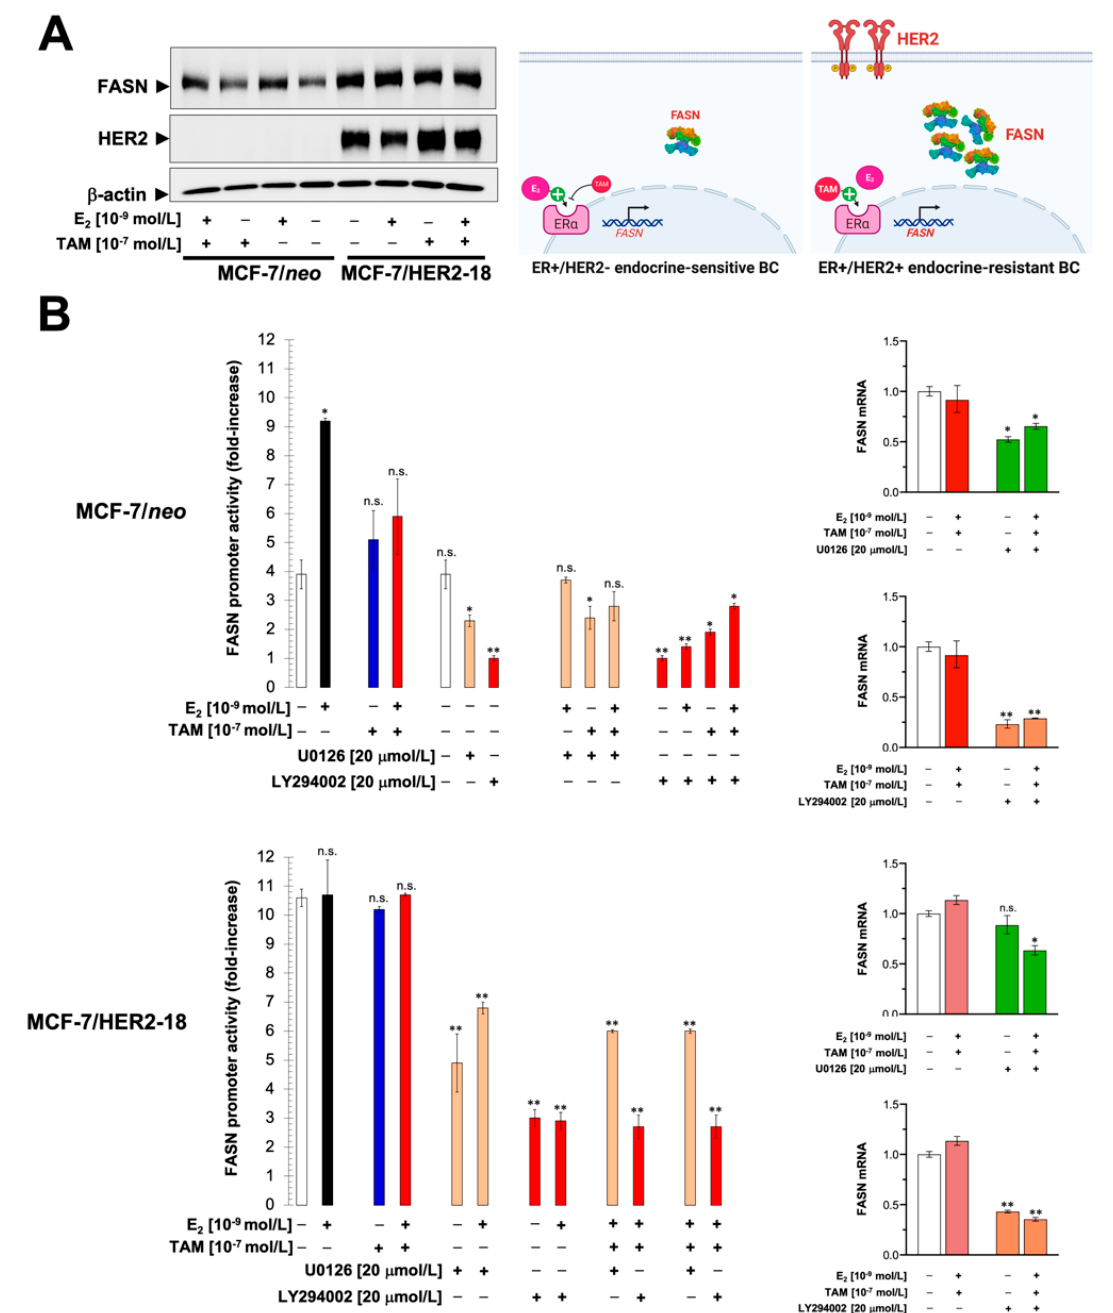
Figure 2. Estradiol and tamoxifen-unresponsive regulation of FASN expression in ER/HER2-positive breast cancer cells. ( A ) FASN protein expression in MCF-7/ neo and MCF-7/HER2-18 cells cultured in the presence or absence of estradiol (E 2 ), tamoxifen (TAM), or their combinations. Shown is a representative immunoblotting analysis. Similar results were obtained in 3 independent experiments. ( B) Left. FASN promoter activity in MCF-7/neo and MCF-7/HER2-18 cells cultured in the absence or presence of estradiol (E 2 ), tamoxifen (TAM), the MAPK inhibitor U0126, the PI3K inhibitor LY294002 or their combinations, was carried out as in Figure 1B. * p < 0.05 and ** p < 0.005, statistically significant differences from the untreated (control) group. Right. Total RNA from MCF-7/neo and MCF-7/HER2-18 cells was characterized in technical triplicates for the abundance of FASN mRNA relative to housekeeping genes GADPH and 18S. The transcript abundance was calculated using the delta Ct method and presented as relative quantification. * p < 0.05 and ** p < 0.005, statistically significant differences from the untreated (control) group. HER2: human epidermal growth factor receptor 2. n.s. not significant. The uncropped blots are shown in Supplementary